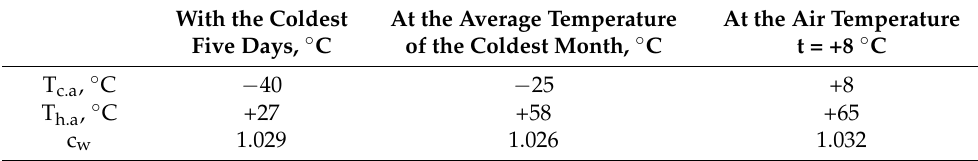
At the Air Temperature t = +8 ◦